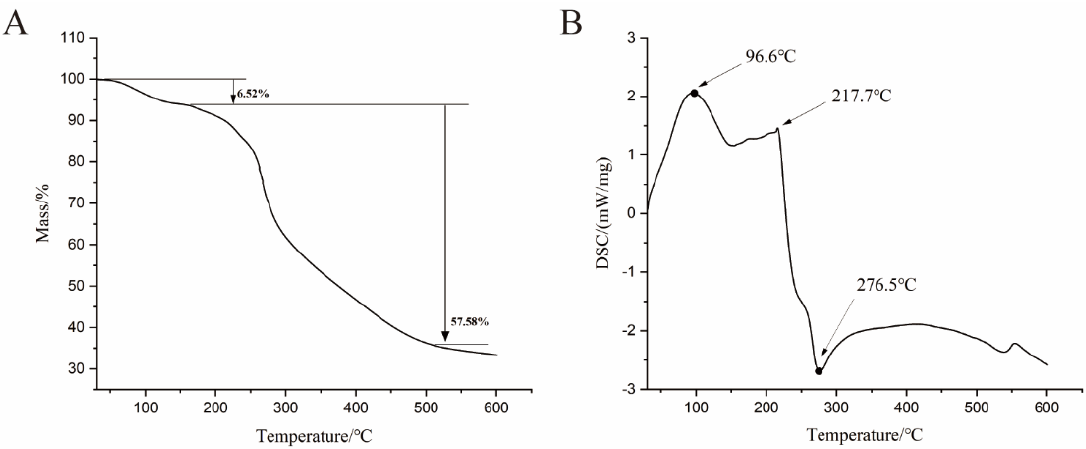
Figure 5. ( A ) TG and ( B ) DSC curves of PF40.